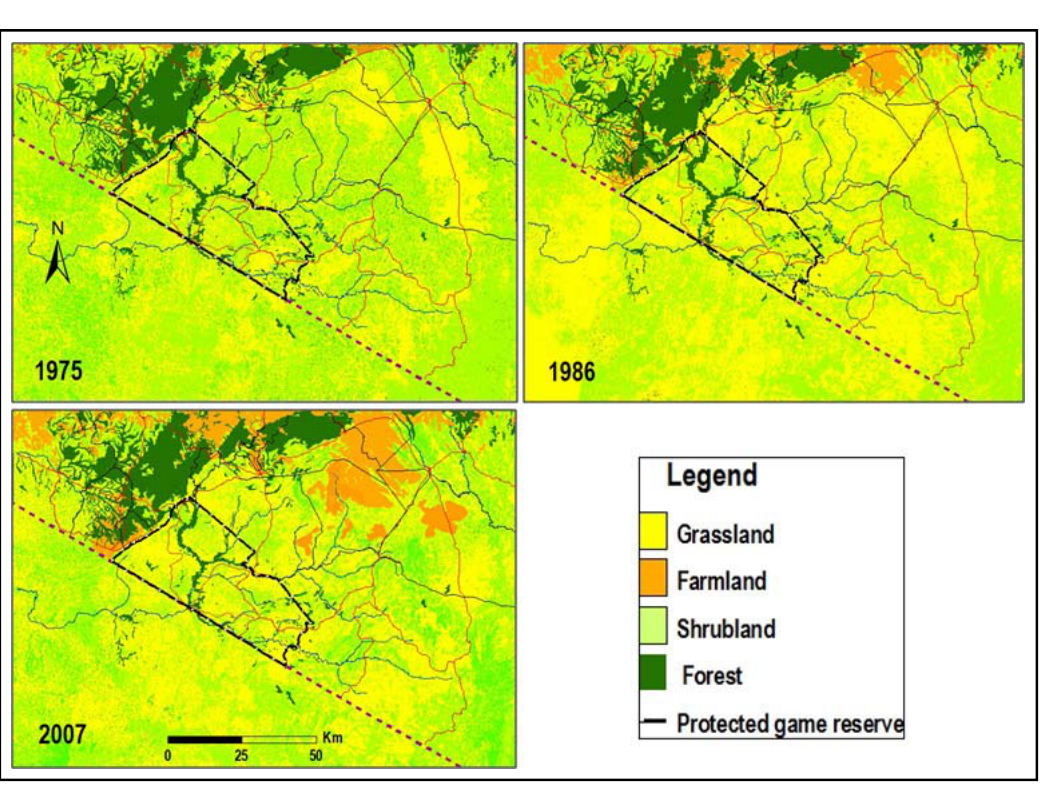
Figure 4. Land use/cover maps of Masai Mara Ecosystem derived from satellite data for 1975, 1986 and 2007.